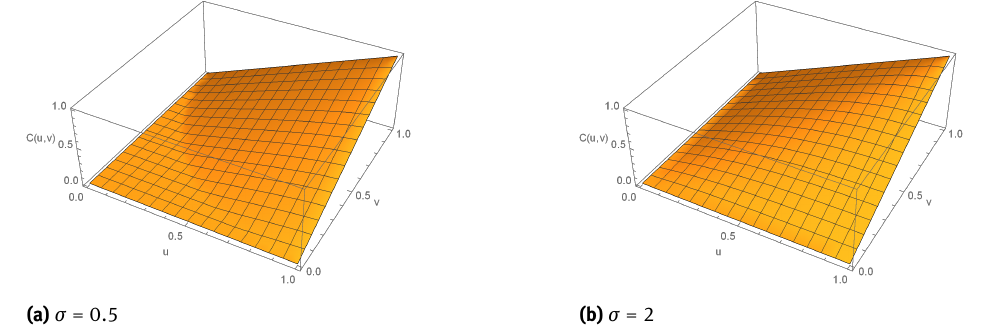
Figure 2: Surfaces of a lognormal Lorenz copula for different values of σ .